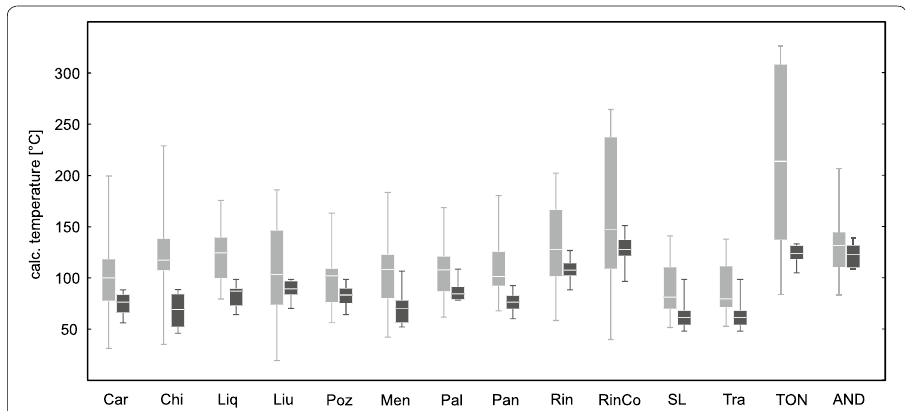
Fig. 4 Distribution of temperatures calculated for the Villarrica springs and the laboratory batch experiments [ TON tonalite experiment (180 days), AND andesite experiment (180 days)] using classical solute geother- mometers ( light grey ) compared to temperature distributions derived from multicomponent geothermom- etry ( dark grey ). Classical solute geothermometer temperatures (SiO 2 , Na/K, Na/K/Ca, K/Mg, Li/Mg and Na/Li) were calculated using formulations of Arnórsson (1983), Can (2002), Diaz-Gonzalez et al. (2008), Fouillac and Michard (1981), Fournier (1977, 1979), Fournier and Potter (1982), Fournier and Truesdell (1973), Giggenbach (1988), Kharaka and Mariner (1989), Michard (1990), Nieva and Nieva (1987), Tonani (1980), and Verma and Santoyo